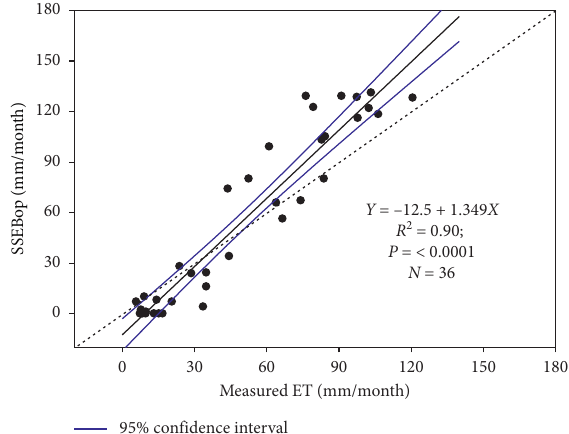
Figure 4: Monthly (mm/month) evapotranspiration (ET; x -axis) plotted against estimated ET by the SSEBop ( y -axis) at pasture flux tower location site during 2016–2018. Model performances are assessed using coefficient of determination ( R 2 ). Also shown are the 1: 1 (dashed line), regression line (solid line), and 95% CI (blue